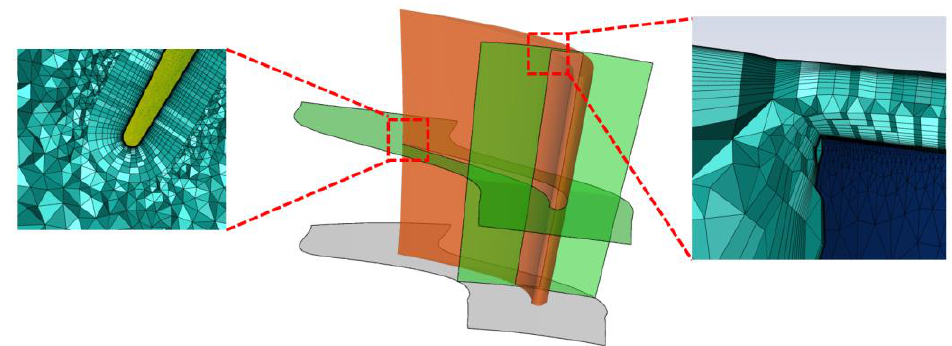
Figure 2. Mesh details near the vane trailing edge and tip gap.